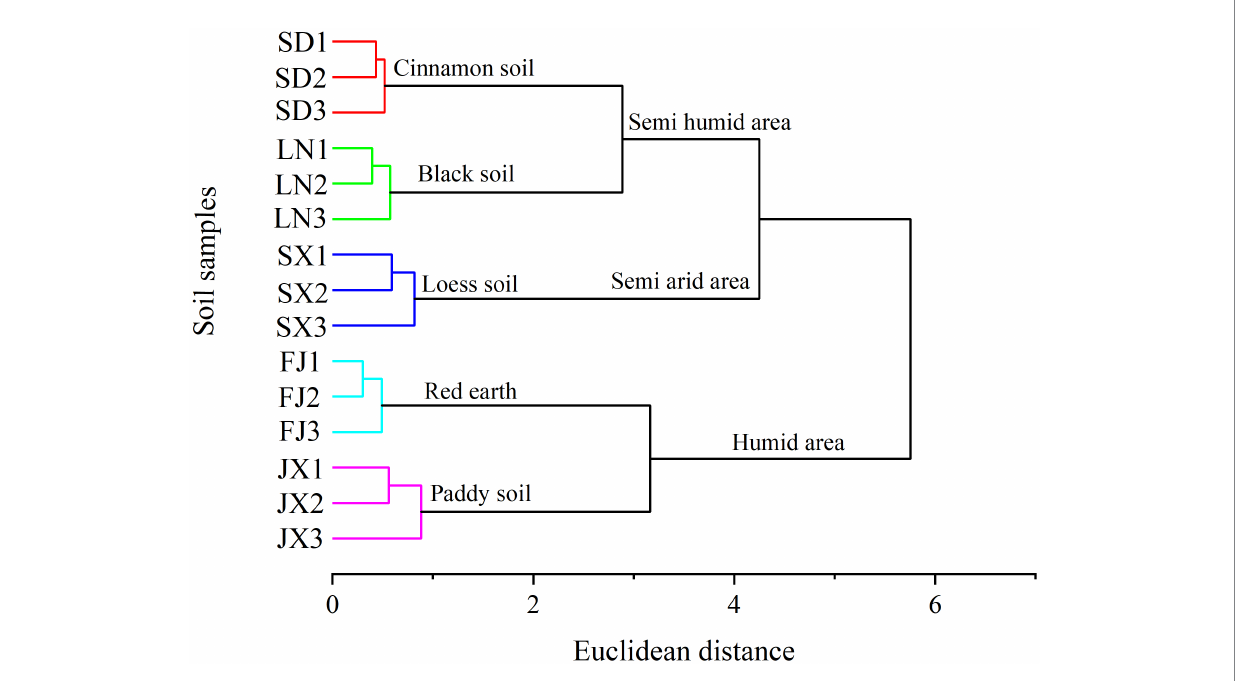
FIGURE 2 Dendrogram from cluster analysis applied to soil characteristics data (Table